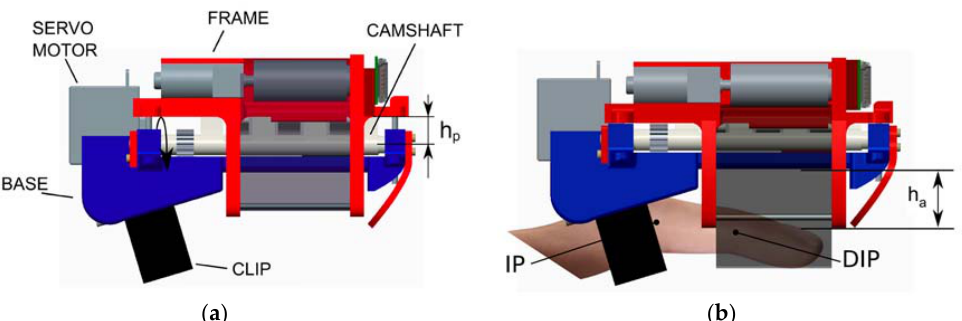
Figure 4. Passive mode: The fabric frame is put in contact with the user’s finger by the camshaft lifting mechanism and servo-motor, inducing a variation of hp (commanded servo motor position) of the frame ( a ); active mode: The user can indent the fabric by flexing the interphalangeal proximal joint of the index finger (IP), while fabric indentation ha can be measured through a contactless infrared sensor ( b ). Reproduced from [18], Copyright 2016, IEEE.